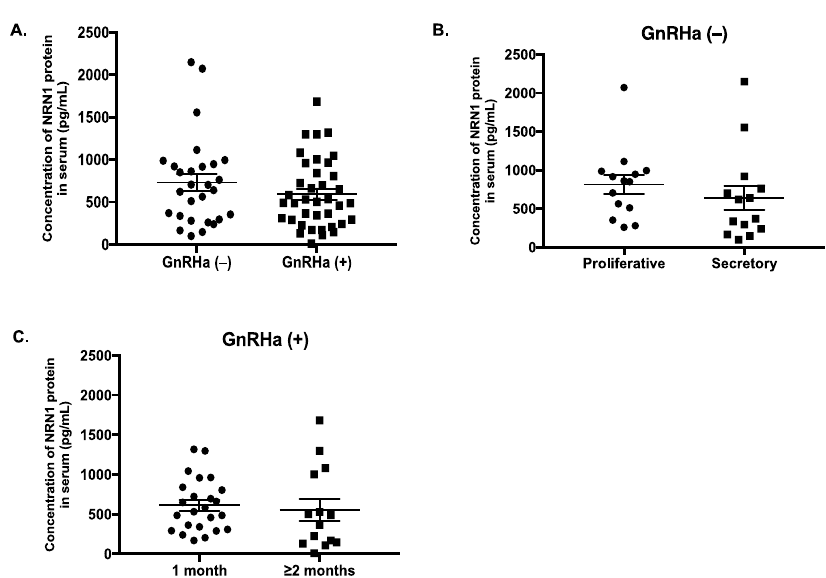
Figure 5. Level of NRN1 in serum of women with endometriosis was measured by ELISA. ( A ) Serum level of NRN1 in patients who were treated with gonadotrophin-releasing hormone agonist (GnRHa ( + ), n = 38) and in those who were not treated with the GnRHa (GnRHa ( − ), n = 28). ( B ) The level of NRN1 in the serum from the GnRHa ( − ) group in the proliferative ( n = 14) and secretory ( n = 14) phases of the menstrual cycle. ( C ) The level of NRN1 in the serum in the GnRHa ( + ) group in patients who were treated for 1 month ( n = 24) and those who were treated for ≥ 2 months ( n = 14). The non-parametric Mann–Whitney U test was used for statistical analysis. The data are expressed as the mean ± the standard error. Significance was set at p < 0.05. n , number of patients; tx, treatment.